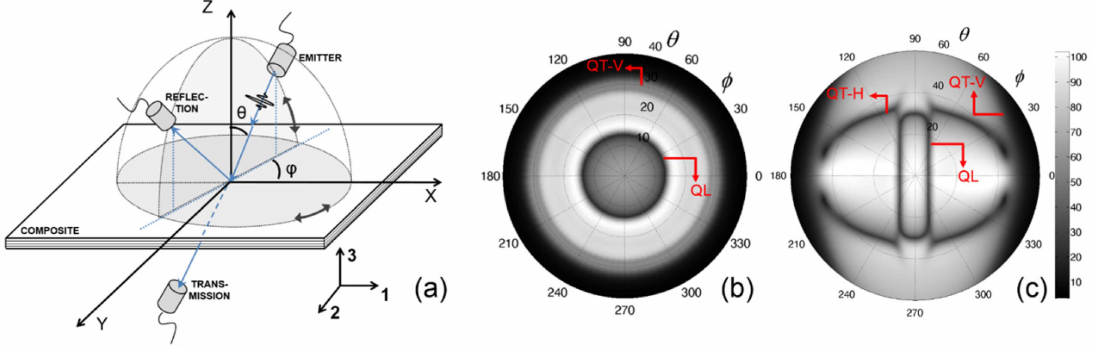
Figure 1. Schematic of ultrasonic polar scan (UPS) method ( a ). State-of-the-art pulsed ultrasonic polar scan (P-UPS) recordings at f c = 5 MHz: aluminum with thickness d = 0.6 mm ( b ) and [0 ˝ ] 8 C/E laminate with thickness d = 1.1 mm ( c ). “QL”, “QT-H” and “QT-V” stand for quasi-longitudinal wave and quasi-transverse wave with horizontal and vertical polarization